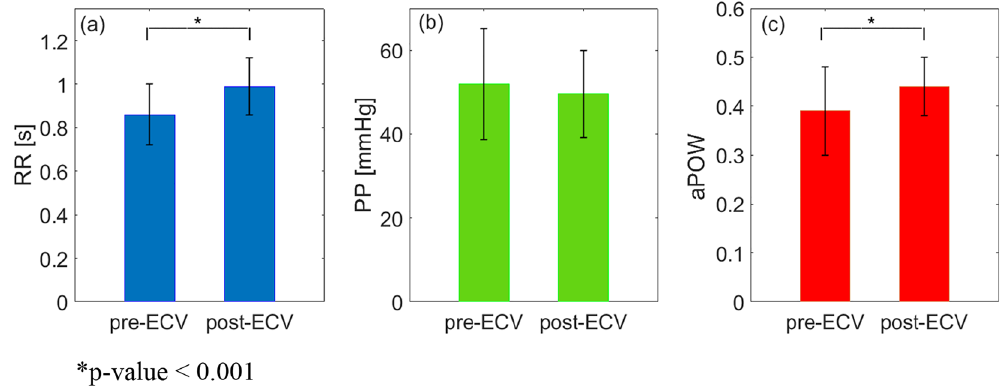
Figure 3. Mean and standard deviation of RR interval, pulse ABP and aPOW signals in the 46 patients included in the signal post-processing phase. * p -value < 0.001.